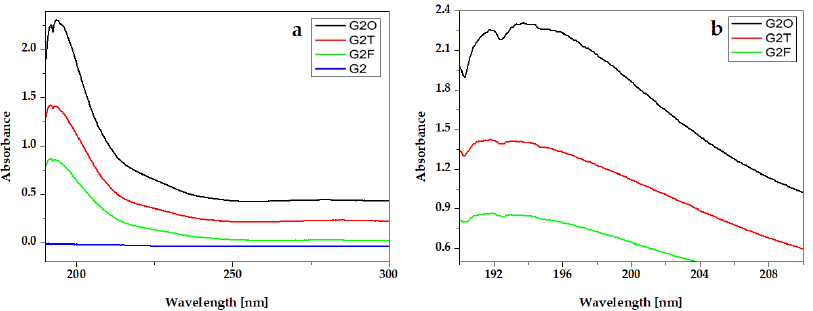
Figure 6. UV-VIS absorption spectra of experimental gels G2 with Oregano ® (G2O), Thieves ® (G2T), and Frankincense ® (G2F) essential oils: ( a ) full-length spectra and ( b ) peaks details.